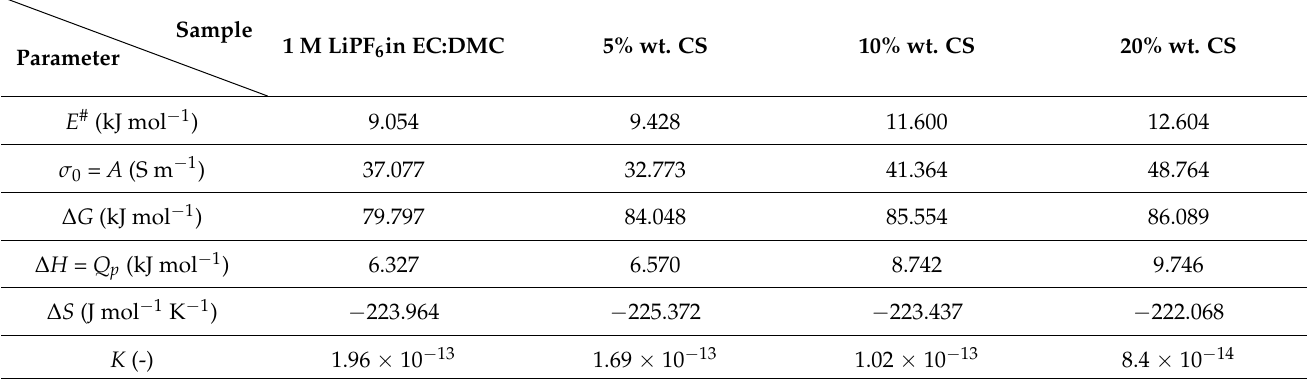
Table 3. Average kinetic and thermodynamic parameters of pure electrolyte and with CS